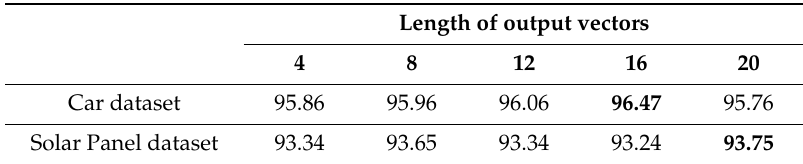
Table 4. Accuracy versus the length of output vectors in primary caps: Left: Car dataset, Right: Solar Panel